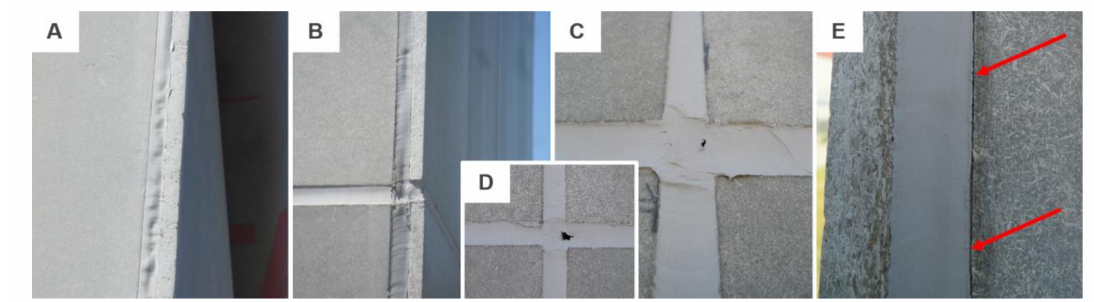
Figure 8. Examples of failure modes: ( A , B ) extrusion found on the south-east façade; ( C , D ) softening found on the front façade; ( E ) adhesive